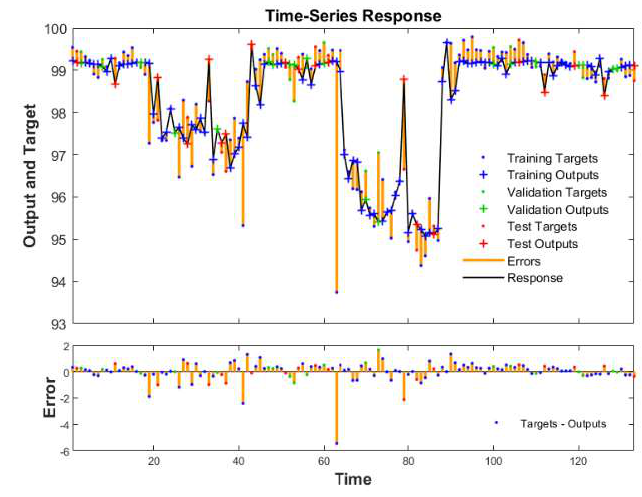
Figure 11. The time−series response. Figure 11. The time − series response.